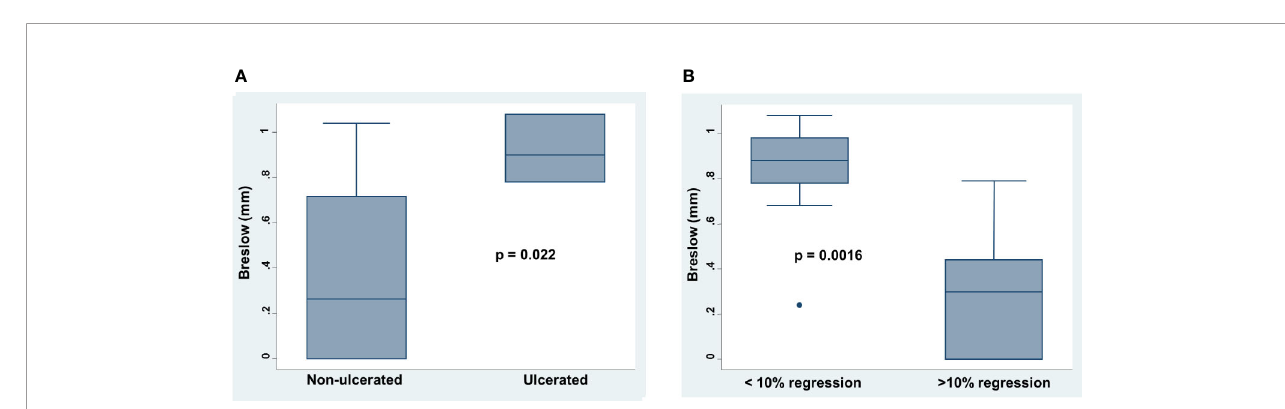
FIGURE 2 | Correlation between Breslow depth , presence of ulceration and tumor regression in thin melanoma. (A) Presence or absence of ulceration was correlated to Breslow depth by Mann-Whitney U test. (B) Presence or absence of regression at 10% cut off of extension was correlated to Breslow depth by Mann- Whitney U test. On each box, the central mark is the median, the edges of the box are the 25 th and 75 th percentiles, the whiskers extend to the most extreme data points note considered outliers, and outliers are plotted individually. p was considered signi fi cant if < 0.05.